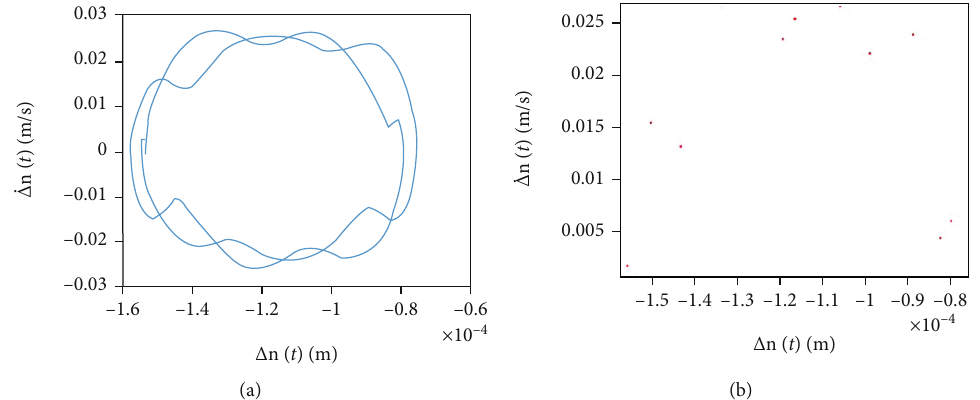
Figure 19: When the wear is 5 : 168 × 10 − 5 m (the misalignment in the x direction is 2 : 8 × 10 − 4 m): (a) relative displacement velocity and (b) the corresponding diagram of